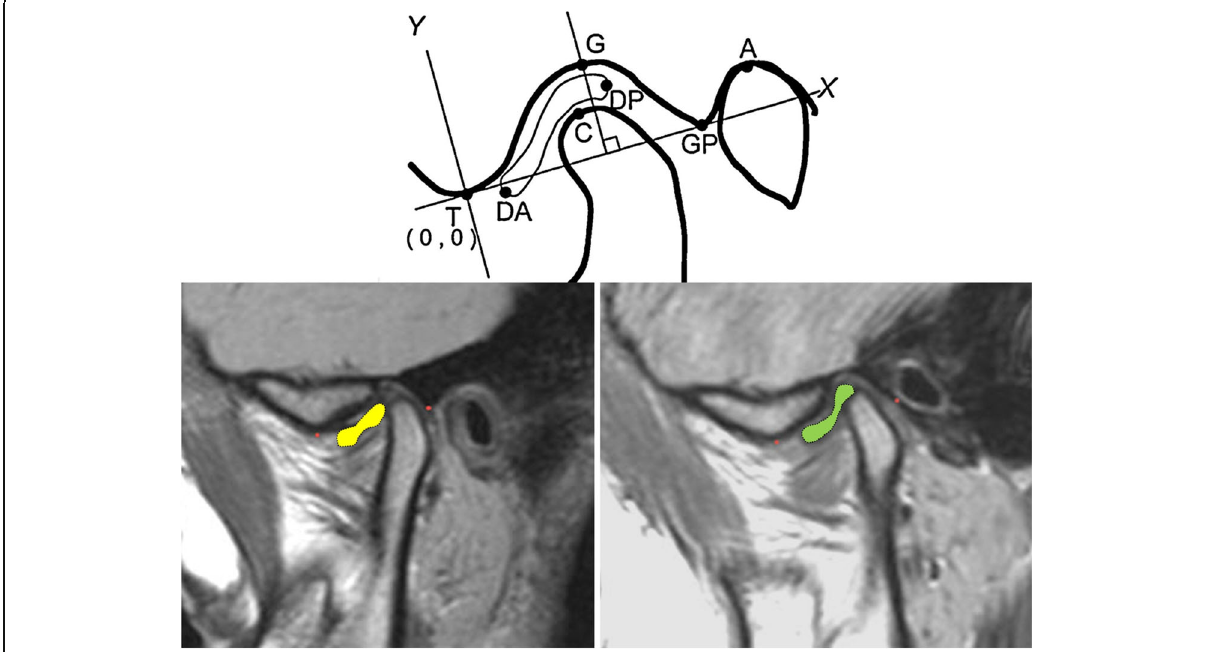
Fig. 7 Image showing a graphical representation of the point system used to locate the articular disc on the MRI (adapted from Arayasantiparb et al. [1] [top]). MRIs of one of our patients, preoperative left and postoperative left. Red points identify the T (lowest point of eminence will mark (0,0) on the ( x , y ) graph) and GP (posterior glenoid tubercle) (will mark (10,0) point of the ( x , y ) graph to be drawn). The discs are coloured for visualization [bottom]. Point DA, anterior-most convexity of the articular disc; point DP, posterior most convexity of the articular disc; point C, uppermost point of the mandibular condyle; point GP, lower-most point of the posterior glenoid tubercle; point A, uppermost point of the external auditory